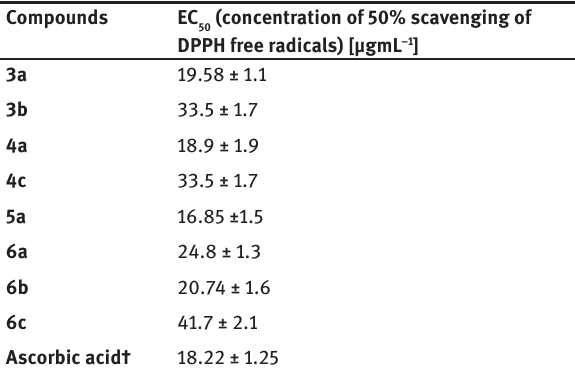
Table 4: In-vitro antioxidant activity by DPPH free radical scavenging